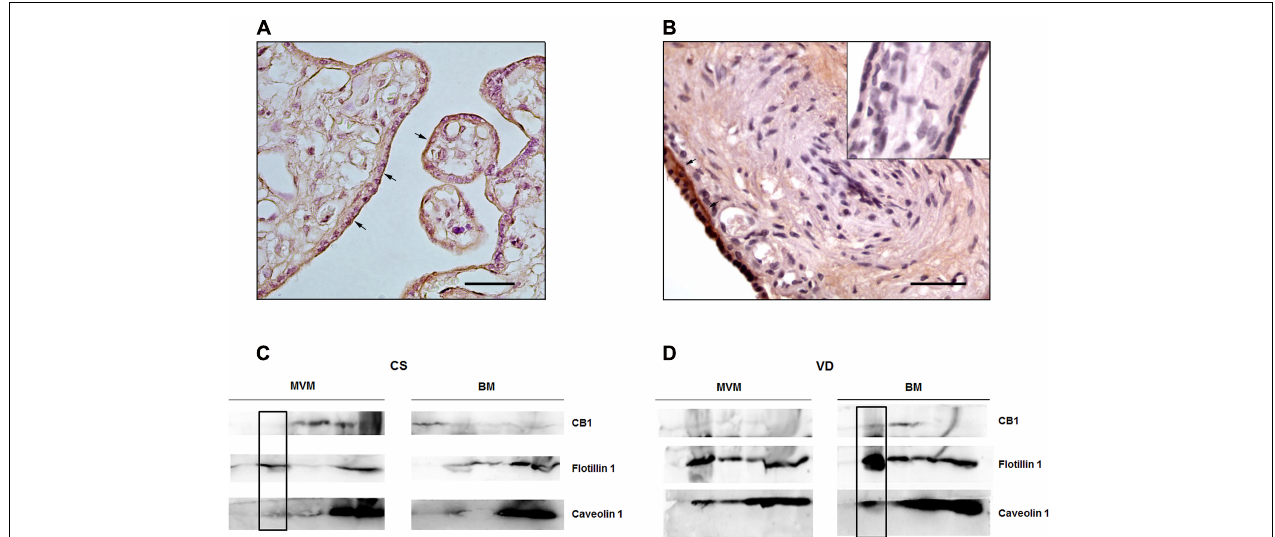
FIGURE 4 | Analysis of CB1 localization in the syncytiotrophoblast of term placenta. Immunolocalization of CB1 in representative sections of placental villous from (A) CS placentas and (B) VD placentas. The arrows indicate specific CB1 staining and the inset shows the negative control. Magnification: 40 × . Scale bar: 20 µ m. (C) Differential distribution of CB1, Flotillin 1 and Caveolin 1 in sucrose gradient fraction of apical membrane (MVM) and basal membrane (BM) from CS placentas. CB1 is expressed in MVM in fractions different from fraction number 2. The inset shows that CB1 does not co-localize with Flotillin 1 and Caveolin 1 ( n = 3). (D) Differential distribution of CB1, Flotillin 1 and Caveolin 1 in sucrose gradient fraction of MVM and BM from VD placentas. The inset shows that CB1 co-localizes with Flotillin 1 and Caveolin 1 in BM ( n =